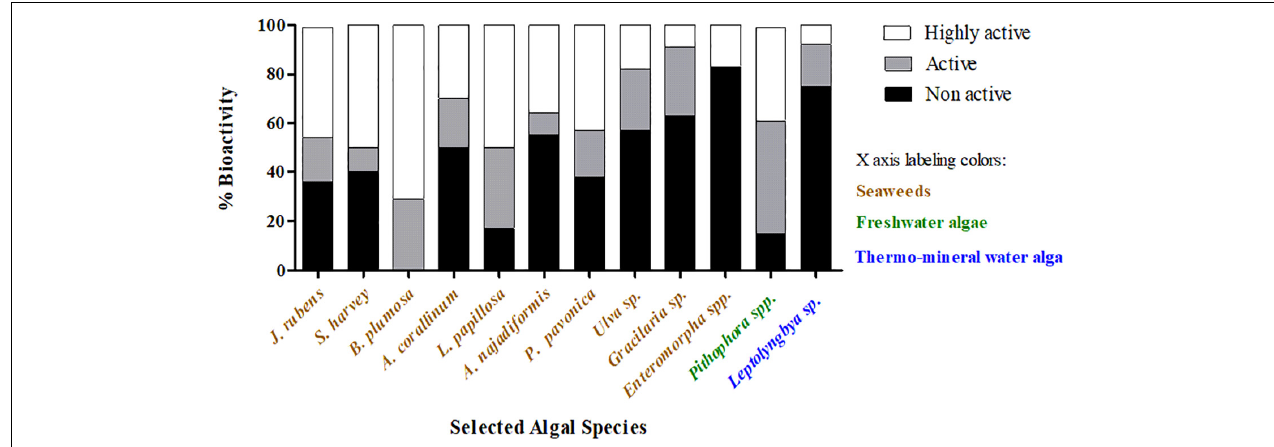
FIGURE 4 | Distribution of the isolated endophytes by algal genera and bioactivity level. Endophytes were isolated from the indicated algae and tested for their bioactivity against aquaculture pathogens. The percentage of bioactivity in each alga was calculated by the number of active/non-active isolates out of the total isolated endophytes. Black bars represent the non-active endophytes, and gray and white bars represent active and highly active isolates, respectively.